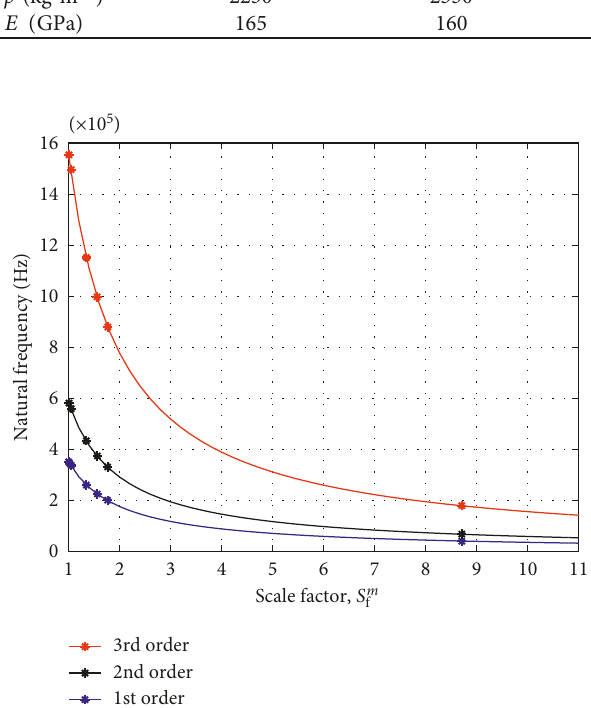
Figure 5: Natural frequencies versus scale factor S m right the asterisk represents polysilicon, silicon, gold, aluminum, nickel, and SU-8, respectively.